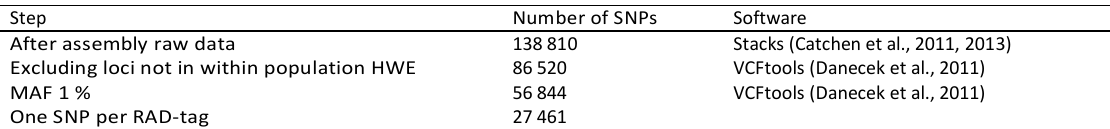
Table 3. Counts of SNP loci after each filtering